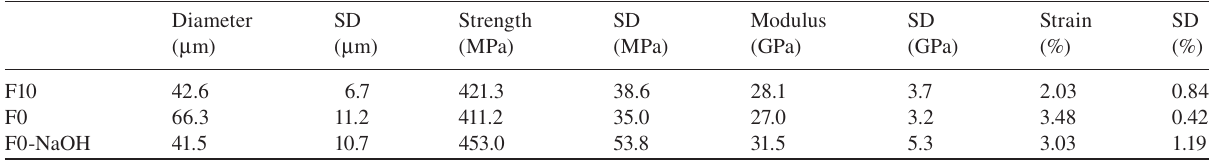
Table 3 Mechanical data of different fl ax fi bers.